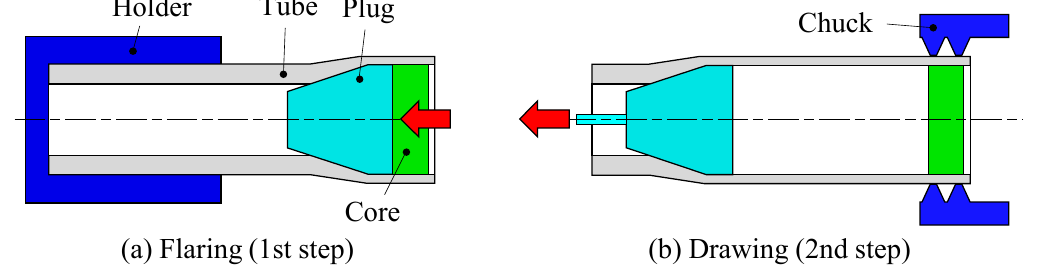
Figure 1. Schematic diagram of drawing process with diameter expansion.